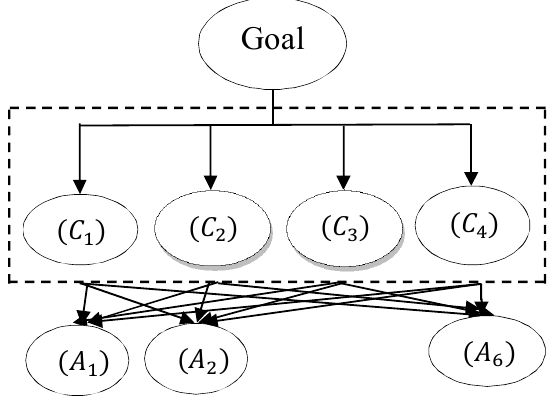
Fig.3. The hierarchy of the problem